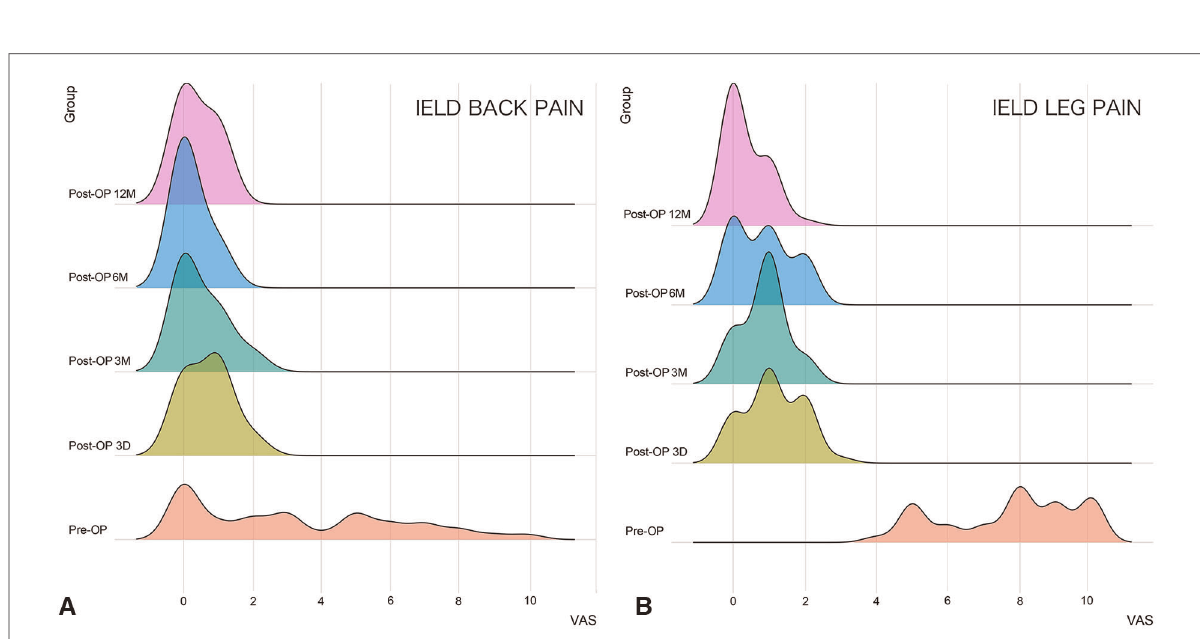
FIGURE 4 ( A ) Comparison of VAS scores for postoperative low back pain in the IELD group at each time point; no signi fi cant differences were noted at 3 days and 3 months postoperatively ( P >0.05). A signi fi cant decrease occurred at 6 months postoperatively compared with that at 3 days and 3 months postoperatively ( P <0.01). No signi fi cant difference was noted between 12 months postoperatively and 3 days, 3 months, and 6 months postoperatively ( P >0.05). ( B ) Comparison of VAS scores for postoperative leg pain in the IELD group at each time point; signi fi cant decreases in VAS scores for postoperative leg pain were noted at 12 months postoperatively compared with that at 3 days, 3 months, and 6 months postoperatively ( P <0.01). No difference was observed between 6 months postoperatively and 3 months postoperatively ( P >0.05); however, a signi fi cant decrease occurred in both groups compared with that at 3 days postoperatively ( P